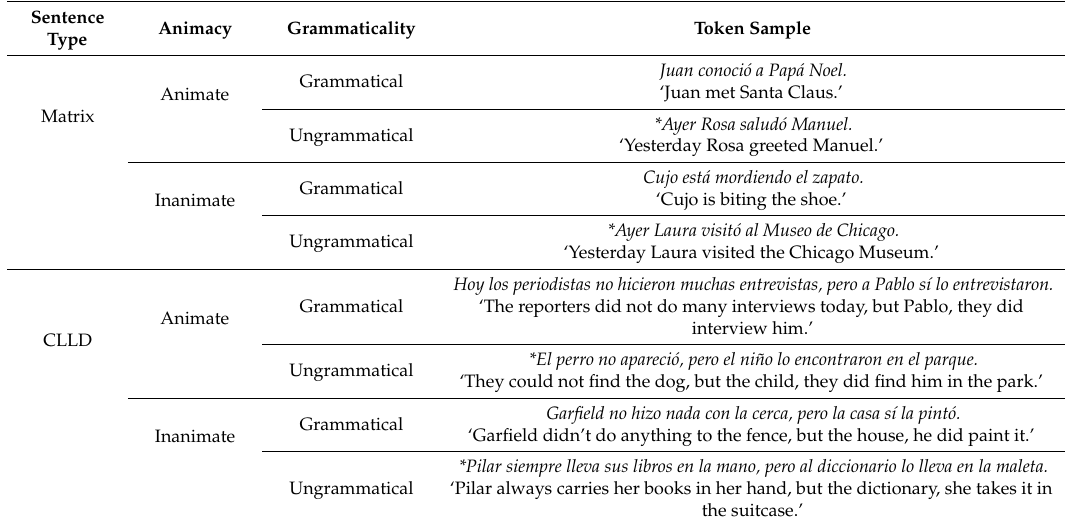
Table 1. Acceptability judgment task (AJT): list of conditions